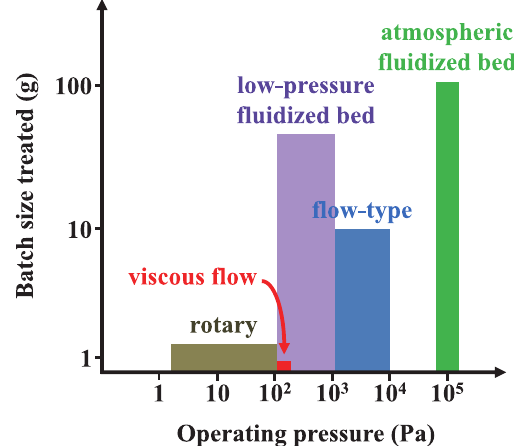
Fig. 3 Categorization of the main research ALD reactors used for particle nanostructuring based on the operating pressure range and maximum batch size reported (log- arithmic